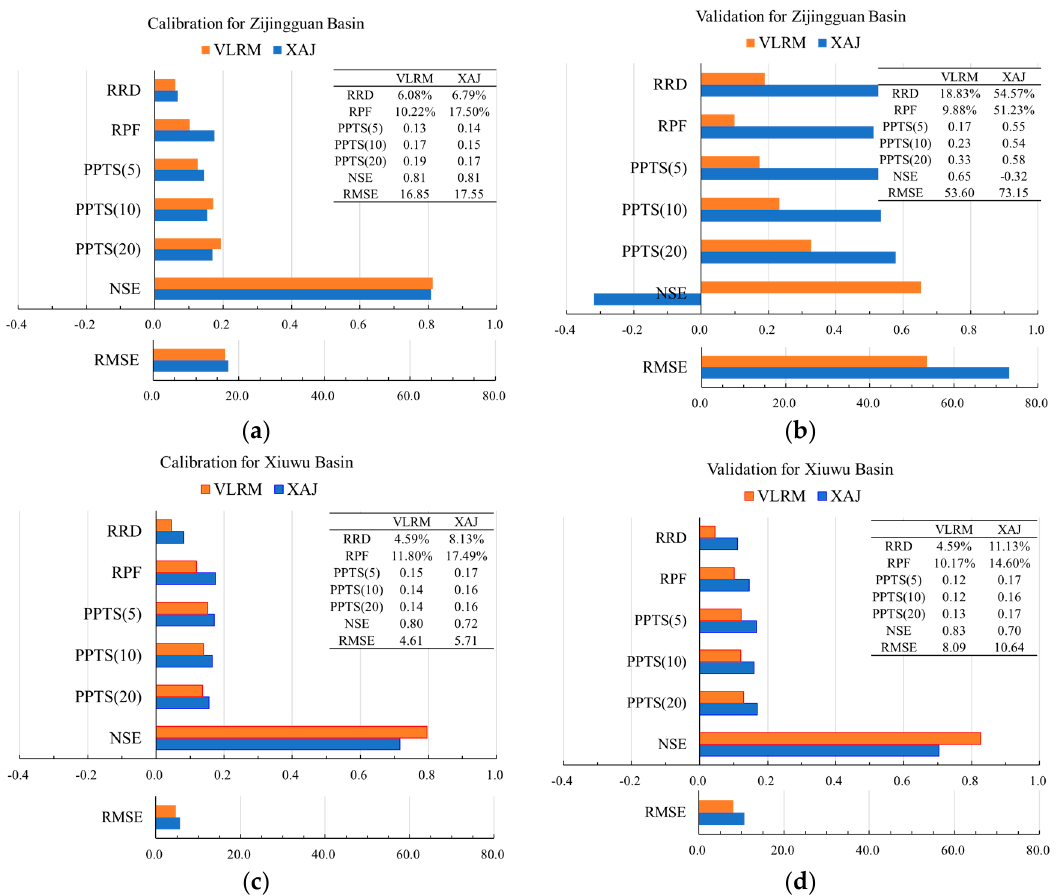
Figure 5. The average values of performance measures for Zijingguan basin in ( a ) calibration and ( b ) validation periods, and for Xiuwu basin in ( c ) calibration and ( d ) validation periods. Note that the RRD and RPF are the averages of the absolute values of RRD and RPF in Tables 2 and 3,